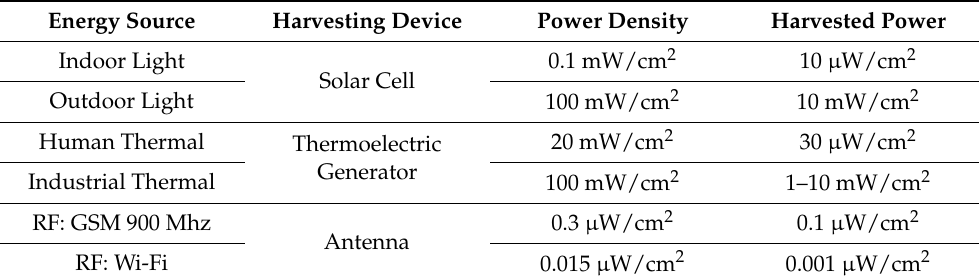
Table 2. The power produced from indoor ambient sources [29]. Energy Source Harvesting Device Power Density Harvested Power Indoor Light 0.1 mW/cm 2 10 µ W/cm 2 Solar Cell Outdoor Light 100 mW/cm 2 10 mW/cm 2 Human Thermal Thermoelectric 20 mW/cm 2 30 µ W/cm 2 Generator Industrial Thermal 100 mW/cm 2 1–10 mW/cm 2